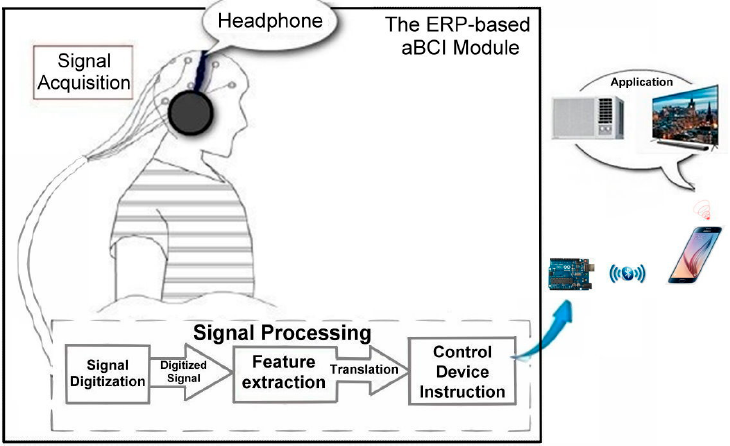
Figure 2. The prototype of the aBCI system. The upper left presents the concept of signal acquisition, the lower the module of signal processing, and the upper right the module of signal application for subsequent